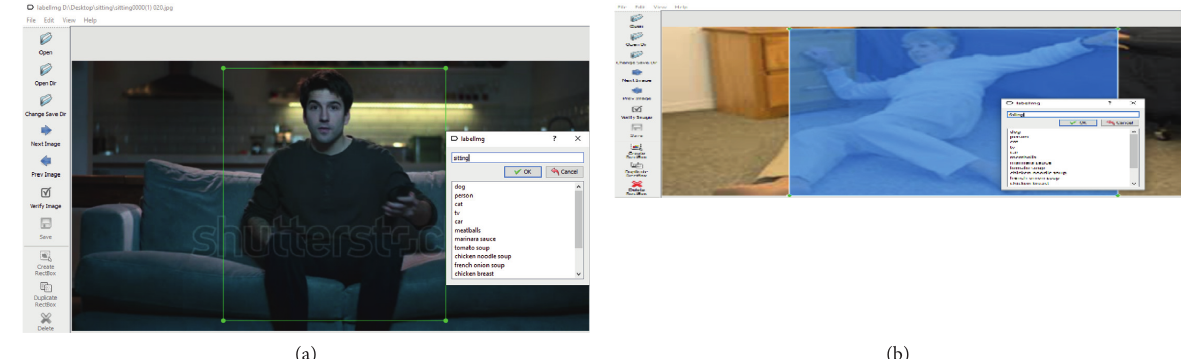
Figure 4: An example of data labeling: (a) sitting down and (b) falling down.